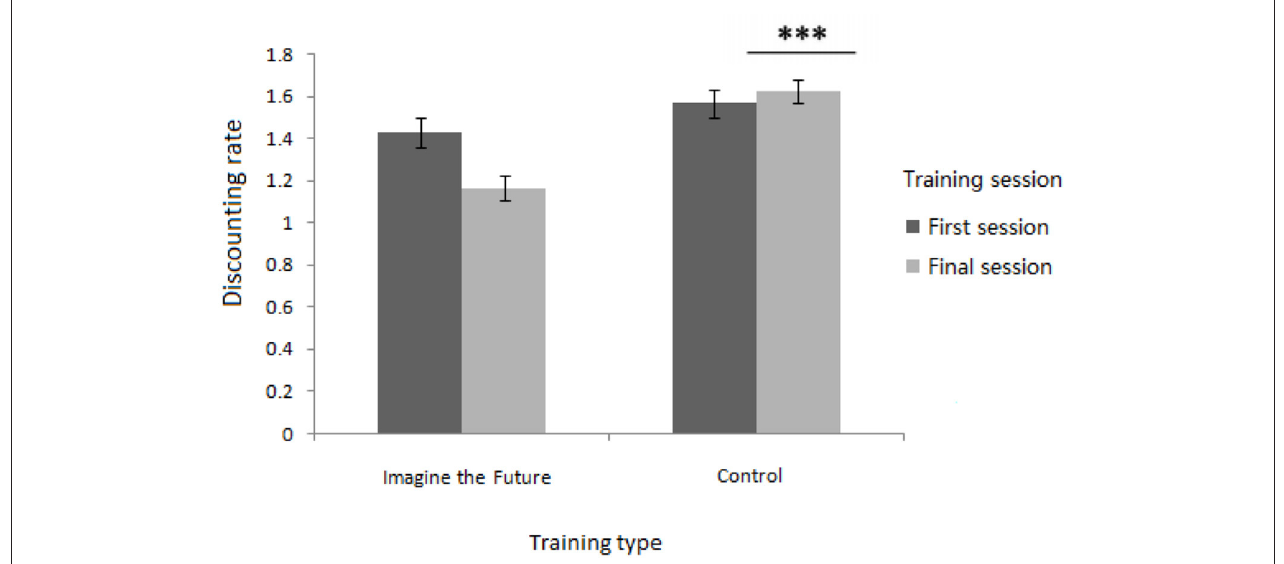
FIGURE 1 | Interaction between the training session and training type for the delay discounting rates (includes mean and SD; ***means p < 0.001).